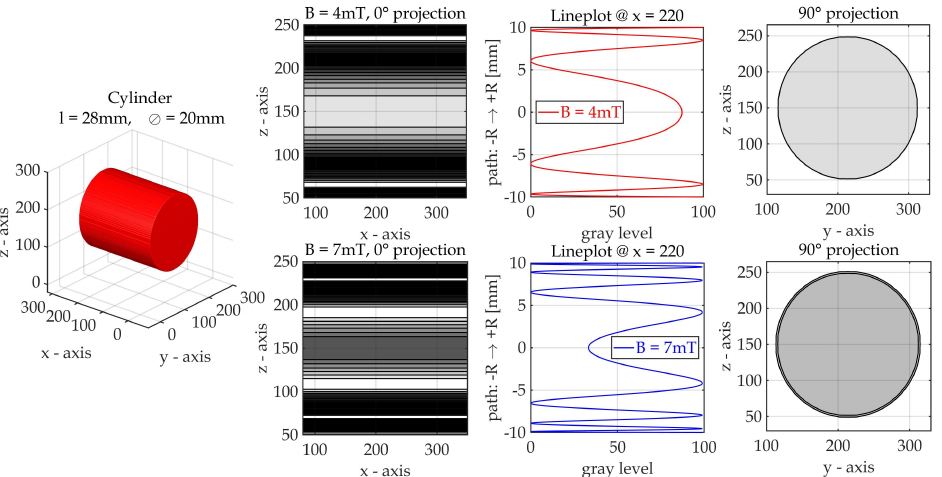
Figure 4. Calculated polarized neutron images: magnetized coil (red) with B-fields = 4 mT and 7 mT, four image projections due to polarized neutron imaging ( λ = 0.32 × 10 − 9 m) for sample orientations 0 ◦ (2) and 90 ◦ (2) with respect to neutron flight direction = y-axis, and the corresponding line plots (cid:82) B · ds . Please note that the B-field is homogeneously illustrating the effect of position-dependent distributed in the coil and therefore produces a homogeneous image at the 90 ◦ projections. The 4 mT B-field produces 5.3 spin flips, the 7 mT B-field 9.2 spin flips, so the gray values for the 90 ◦ orientations are very similar, gray scale =